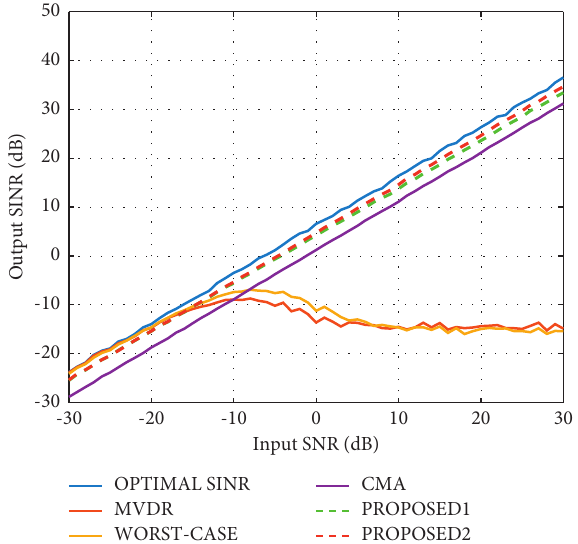
Figure 9: Random look direction mismatch: output SINR versus the input